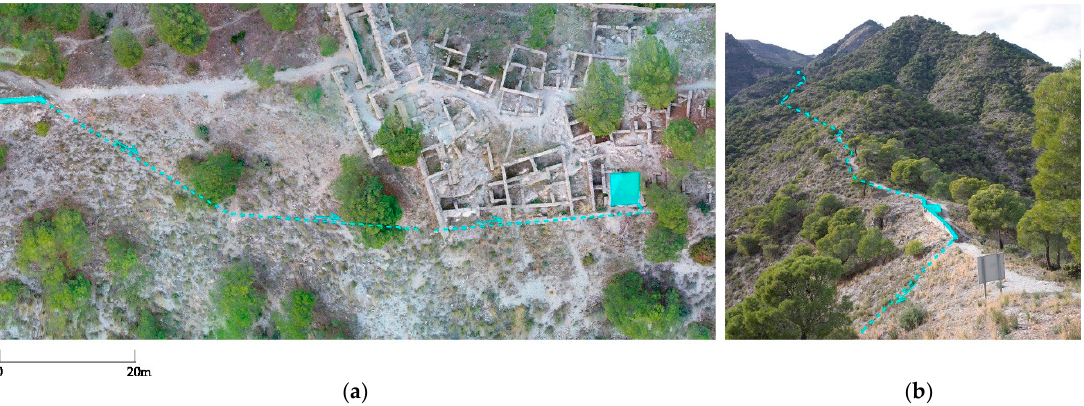
Figure 8. Fortified settlement of Los Guájares. Hypothesis of the water supply system. ( a ) Situation of the cistern ( b ) View of the hill’s summit line, the water tank, and channels. Created by authors.